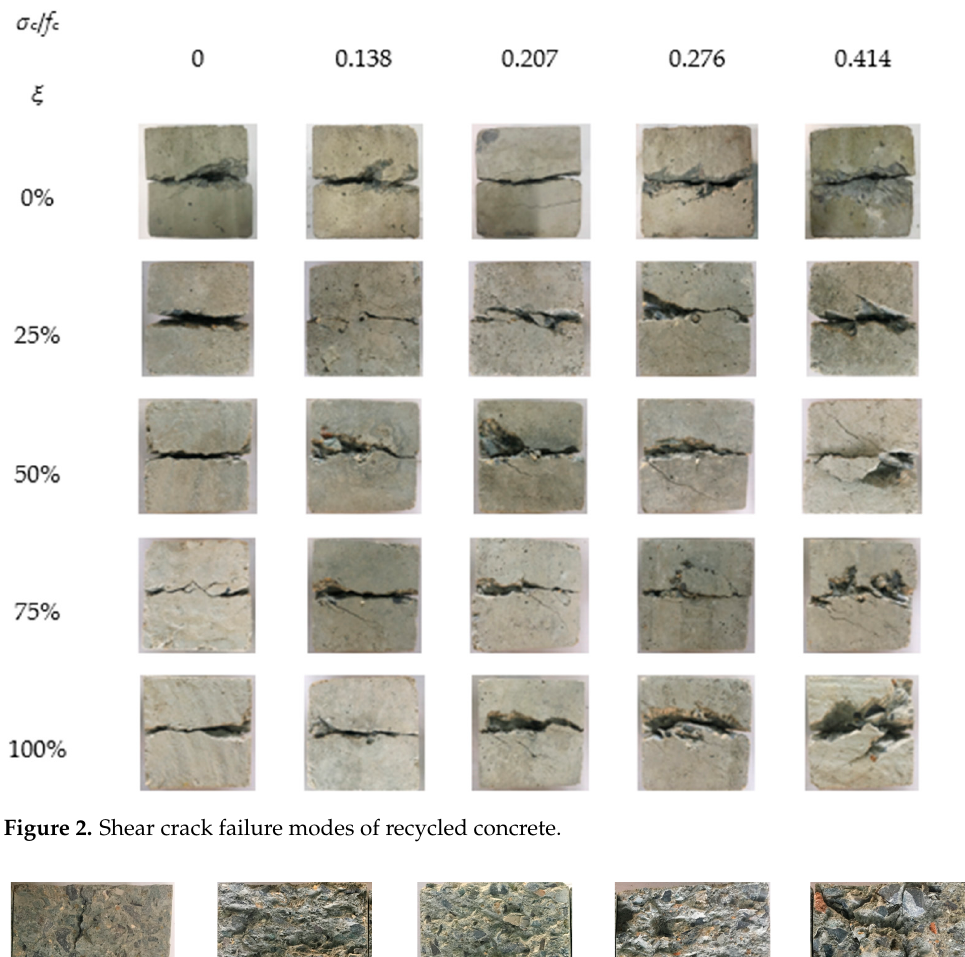
Figure 2. Shear crack failure modes of recycled concrete.